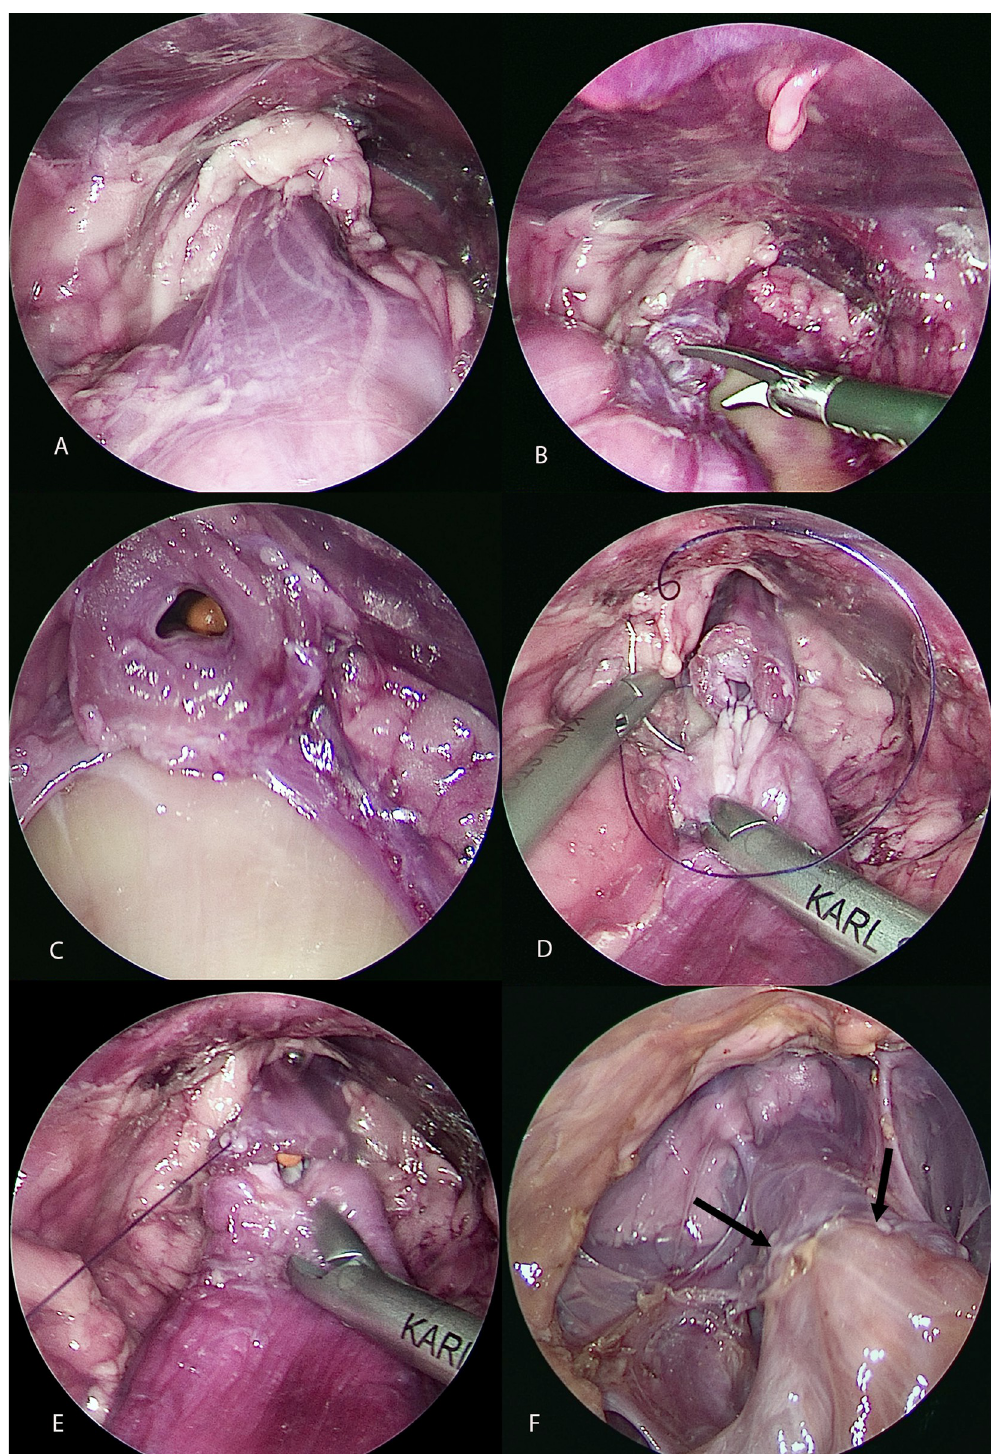
Fig 4. A: The urethra caudal to the prostate is now exposed. B: The urethra is transected caudal to the prostate. C: The urethra is now completely transected, and the urinary catheter is visible. D: The VUA is performed on the dorsal side with a continuous pattern of 4–0 V Loc 90 suture. The suture is placed outside-in in the bladder and inside-out in the urethra. E: The dorsal line of the suture has been completed, and the ventral side is started. F: The VUA is completed (black arrows).